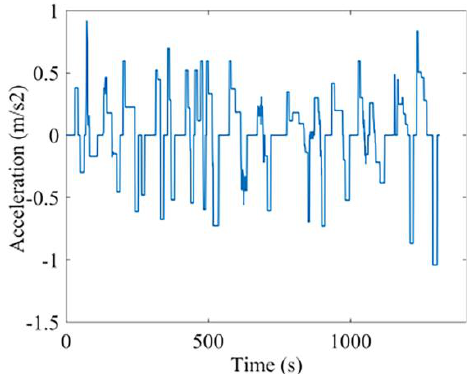
Figure 23. Acceleration.